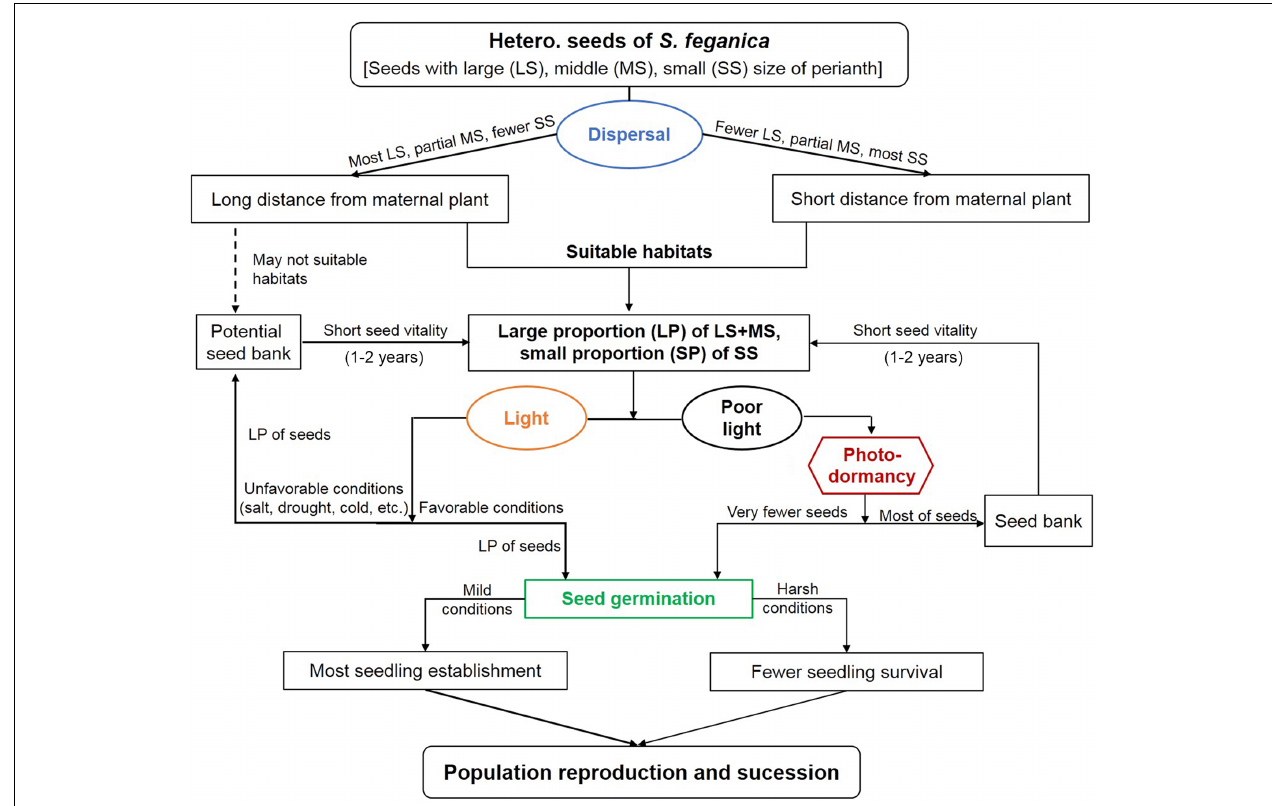
FIGURE 13 | Proposed model of dynamics of reproduction for heteromorphic seeds of S. ferganica under various environmental